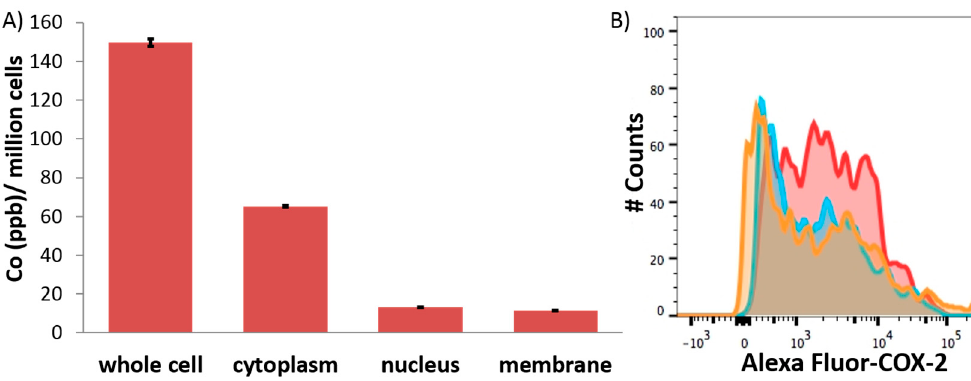
Figure 4. ( A ) Cobalt content in whole cell, cytoplasm, nucleus, and membrane fractions isolated from HMLER-shEcad cells treated with 3 (0.5 µ M for 16 h). ( B ) Representative histograms displaying the green fluorescence emitted by anti-COX-2 (cyclooxygenase-2) Alexa Fluor 488 nm antibody-stained HMLER-shEcad cells treated with lipopolysaccharide (LPS) (5 µ M for 24 h) (red) followed by 48 h in media containing 1 (0.125 µ M: blue and 0.5 µ M: orange).